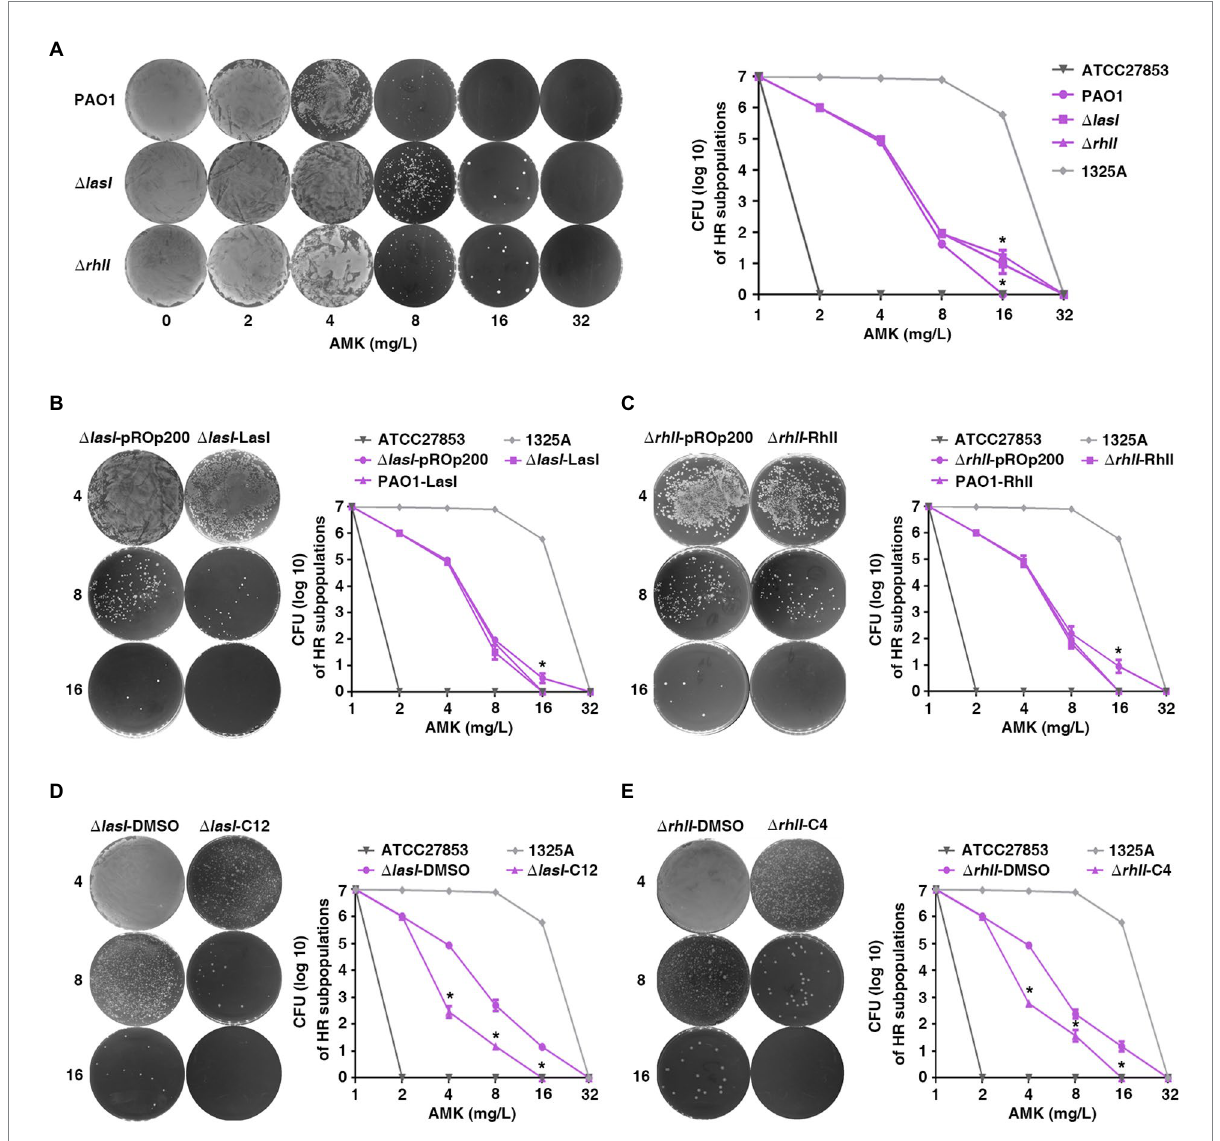
FIGURE 3 The quorum sensing system of P. aeruginosa inhibits heteroresistance. (A) Deficiency of lasI or rhlI in PAO1 enhanced heteroresistance. *, p < 0.05, PAO1 Δ lasI or PAO1 Δ rhlI compared with PAO1; (B,C) Over expression of lasI or rhlI inhibited heteroresistance. *, p < 0.05, Δ lasI -LasI compared with Δ lasI -pROp200; Δ rhlI -RhlI compared with Δ rhlI -pROp200. (D,E) Exogenous 3-oxo-C12-HSL (C12) or C4-HSL (C4) inhibited heteroresistance. The HR tests (PAPs) were carried out on PAO1 Δ lasI and PAO1 Δ rhlI treated with 40 μ M of 3-oxo-C12-HSL and C4-HSL, respectively, *, p < 0.05, Δ lasI -C12 compared with Δ lasI -DMSO; Δ rhlI -C12 compared with Δ rhlI -DMSO. Δ lasI -pROp200: PAO1 Δ lasI strain transformed with pROp200 plasmid; Δ lasI - LasI: PAO1 Δ lasI strain transformed with pROp200 plasmid that expressed LasI; Δ lasI -DMSO: PAO1 Δ lasI strain treated with DMSO; Δ lasI -C12: PAO1 Δ lasI strain treated with 3-oxo-C12-HSL; Δ rhlI -DMSO: PAO1 Δ rhlI strain treated with DMSO; Δ rhlI -C4: PAO1 Δ rhlI strain treated with